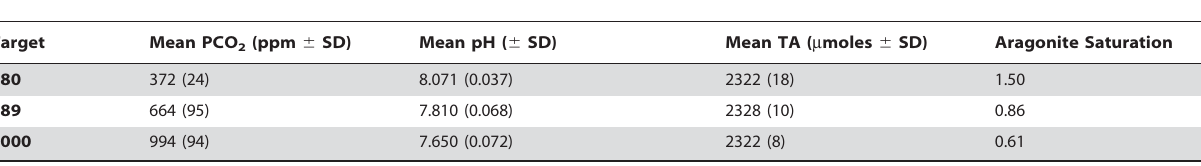
Table 2. Experimental seawater carbonate chemistry at target gas